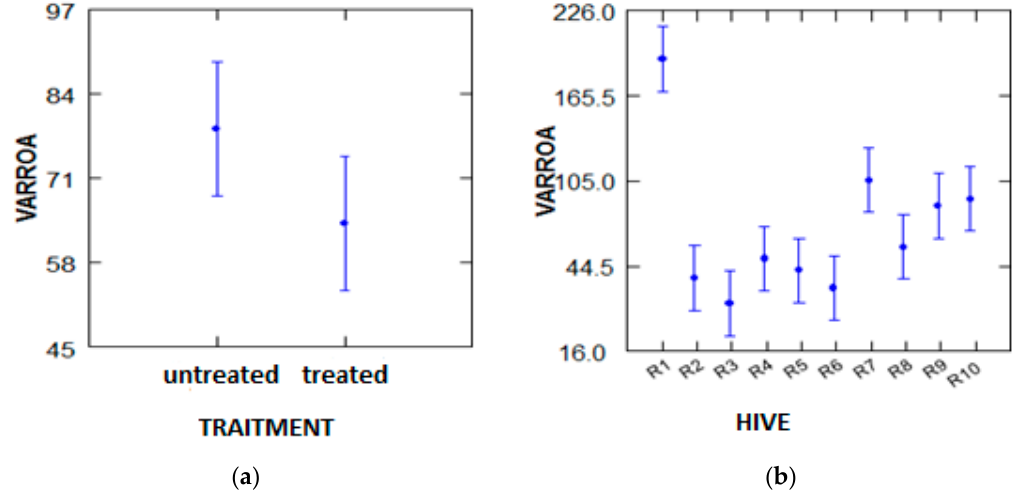
Figure 4. Analysis of the variance of the global number of dead varroa according to the hive factor and treatment. ( a ) Traitment; ( b ) Hive.